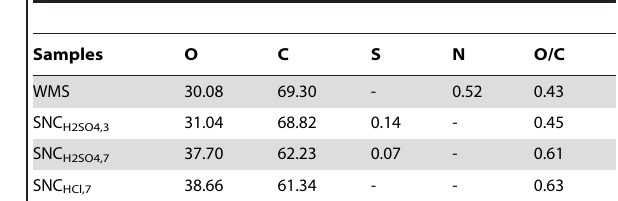
Table 1. Elemental surface composition (atomic %) and oxygen to carbon ratio of starch, HCl- and H 2 SO 4 -hydrolyzed SNC.